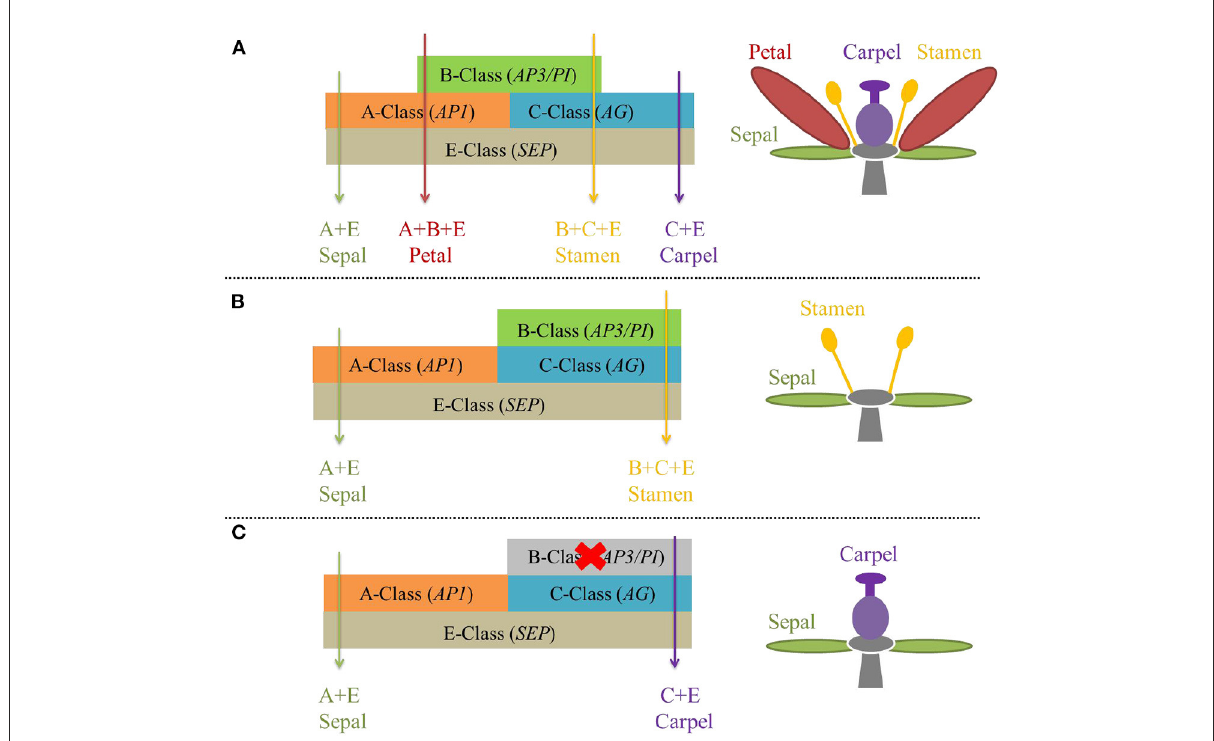
FIGURE3 The “ABCDE model” of flower development, with D genes that specify ovule unshown. (A) B-class gene’s normal expression makes perfect flowers. (B) Shifted and expanded expression domain of B-class genes permits male flowers. (C) Repression of B-class genes gives rise to female